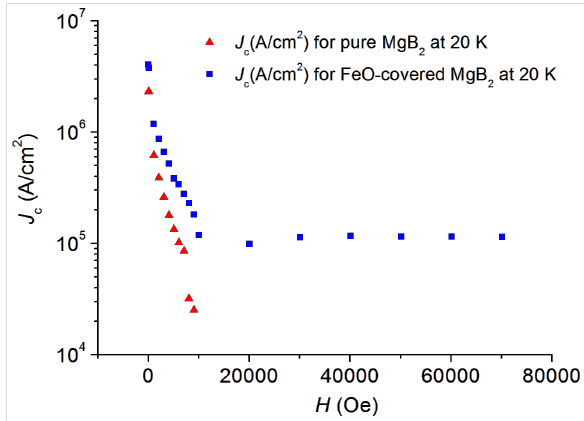
Figure 6: Magnetic-field dependence of the critical current density J c for the pure (red triangles) and for the FeO-covered (blue squares) MgB 2 samples at 20